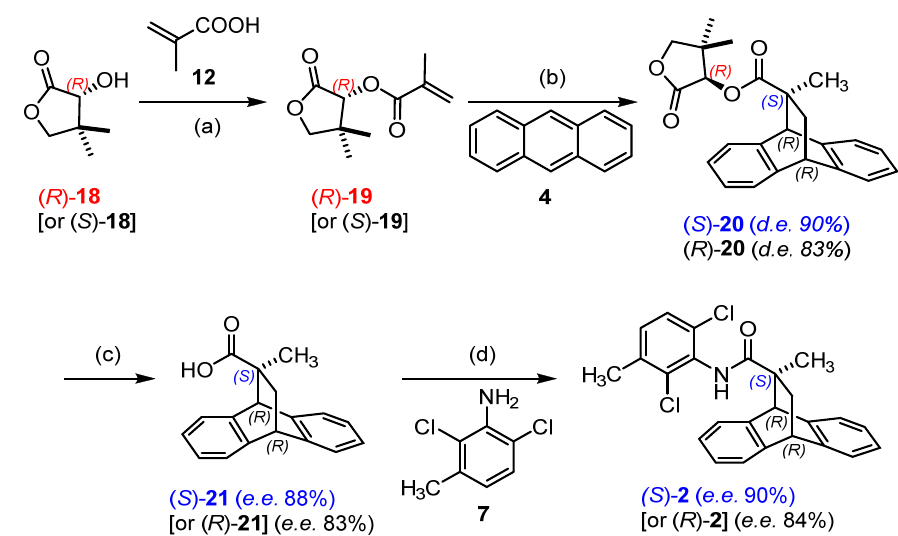
Scheme 4. Enantioenrichment of optical isomers of 2 using chiral auxiliaries derived from pantolac- tone. Reagents and conditions: ( a ) EDCI, DMAP, dry CH 2 Cl 2 , r.t. 10 h, 69–87% (( R )- 19 , ( S )- 19 ); ( b